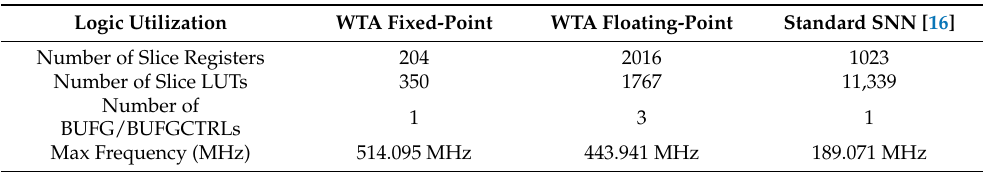
Table 2. Comparison between different types of SNNs in terms of resource utilization and opera- tion